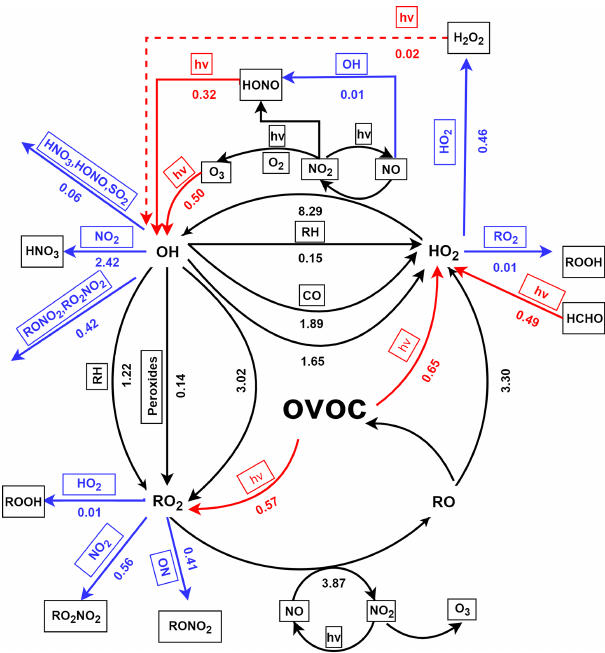
Figure 6. Summary of daytime (06:00–18:00) average budgets of RO x radicals (in ppbvh − 1 ). Primary RO x sources and sinks are in red and blue, respectively, and the black lines represent the pro- cesses in RO x and NO x